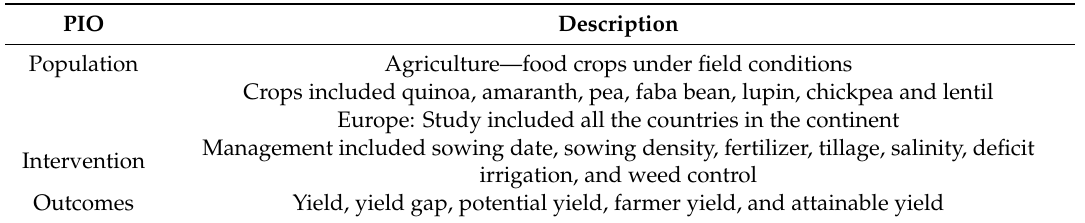
Table 1. Defining the PIO terms for the research ‘question’ used in this study PIO Description Population Agriculture—food crops under field conditions Europe: Study included all the countries in the